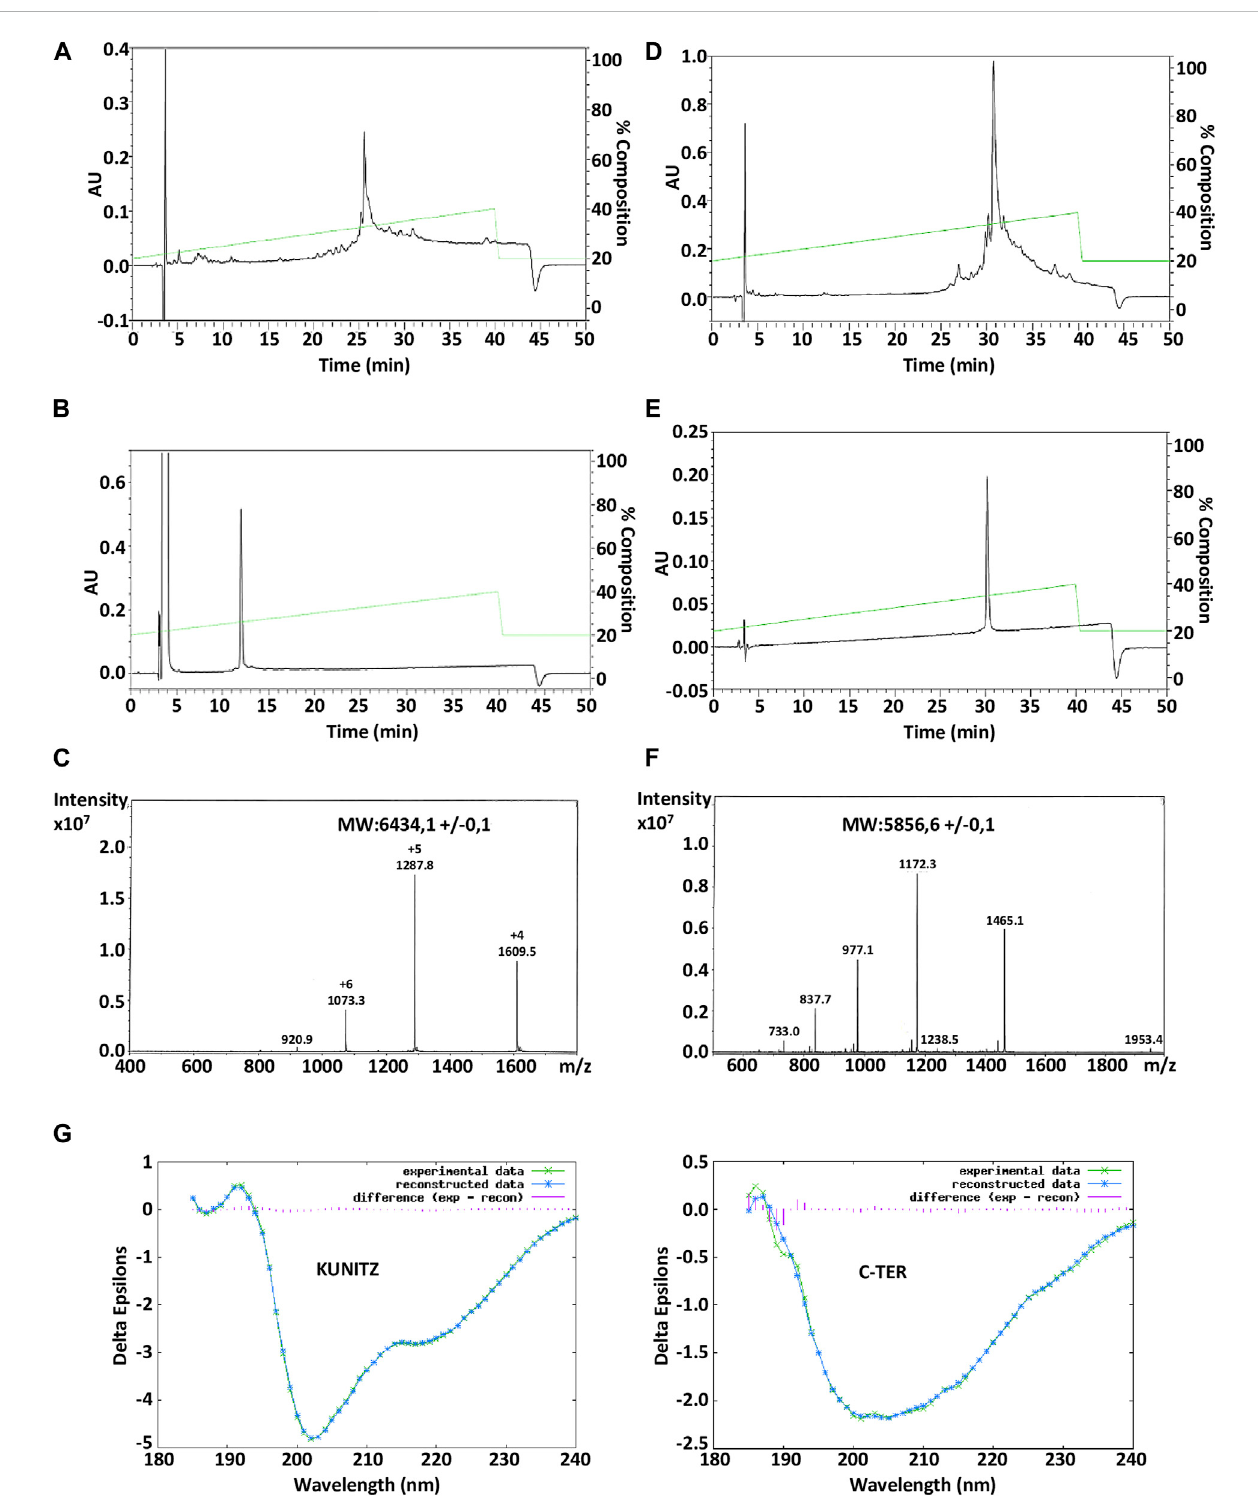
FIGURE 1 HPLC chromatograms of the crude Amblyomin-X-Nter (Kunitz domain) and Amblyomin-X-C-ter directly after cleavage (A , D) and after their refolding and/orpuri fi cation (B , E) .ESImassspectrumoftherefoldedAmblyomin-X-Nter (C) andAmblyominX-C-ter (F) .CirculardichroismanalysisofKunitzandC-ter domains of Amblyomin-X a. The spectra were measured at a peptide concentration of 20 μ M (G)